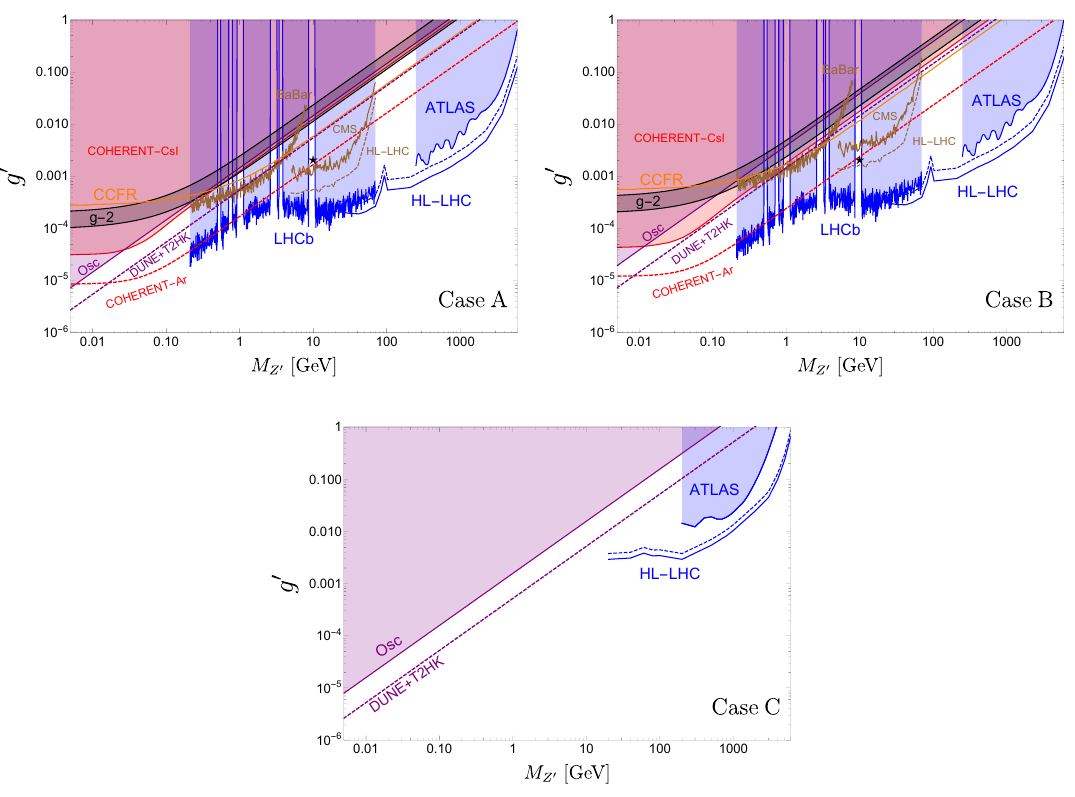
Figure 2. Bounds on g 0 for Cases A (upper left panel), B (upper right panel) and C (lower panel). The red shaded areas correspond to the 2 (cid:27) exclusion regions by using the energy spectrum from the COHERENT CsI detector [9]. The red dashed lines show the expected 2 (cid:27) limit from COHERENT with a 750 kg LAr detector [25] and a 4-year exposure using both energy and time information. The purple areas correspond to the 2 (cid:27) bounds from a global (cid:12)t to neutrino oscillation data [24]. The dashed purple lines show the expected 2 (cid:27) exclusion limit from DUNE and T2HK combined. Regions above the brown curves are excluded by CMS [26] and BaBar [27] at 2 (cid:27) and 90% CL, respectively, using pp=e + e (cid:0) ! (cid:22) + (cid:22) (cid:0) Z 0 searches. The brown dashed curves are the 2 (cid:27) expected sensitivities from HL-LHC, with an integrated luminosity of 3000 fb (cid:0) 1 , in the (cid:22) + (cid:22) (cid:0) Z 0 channel, and the blue solid (dashed) curves correspond to the expected 2 (cid:27) (5 (cid:27) ) limit using di-muon searches for Cases A and B, and di-tau searches for Case C. In the upper panels, the blue shaded regions are excluded at 90% CL by the LHCb dark photon searches [28] and at 2 (cid:27) by the ATLAS di-muon searches [29] with 139 fb (cid:0) 1 . In the lower panel, the blue area is excluded at 2 (cid:27) by the ATLAS di-tau searches [30] with 36.1 fb (cid:0) 1 . The 2 (cid:27) limit from CCFR [31, 32] is given by the orange curves. The 2 (cid:27) allowed regions that explain the discrepancy in the anomalous magnetic moment of the muon ((cid:1) a (cid:22) = (29 (cid:6) 9) (cid:2) 10 (cid:0) 10 [33]) are indicated by the black band. The black stars mark the benchmark points we consider in section